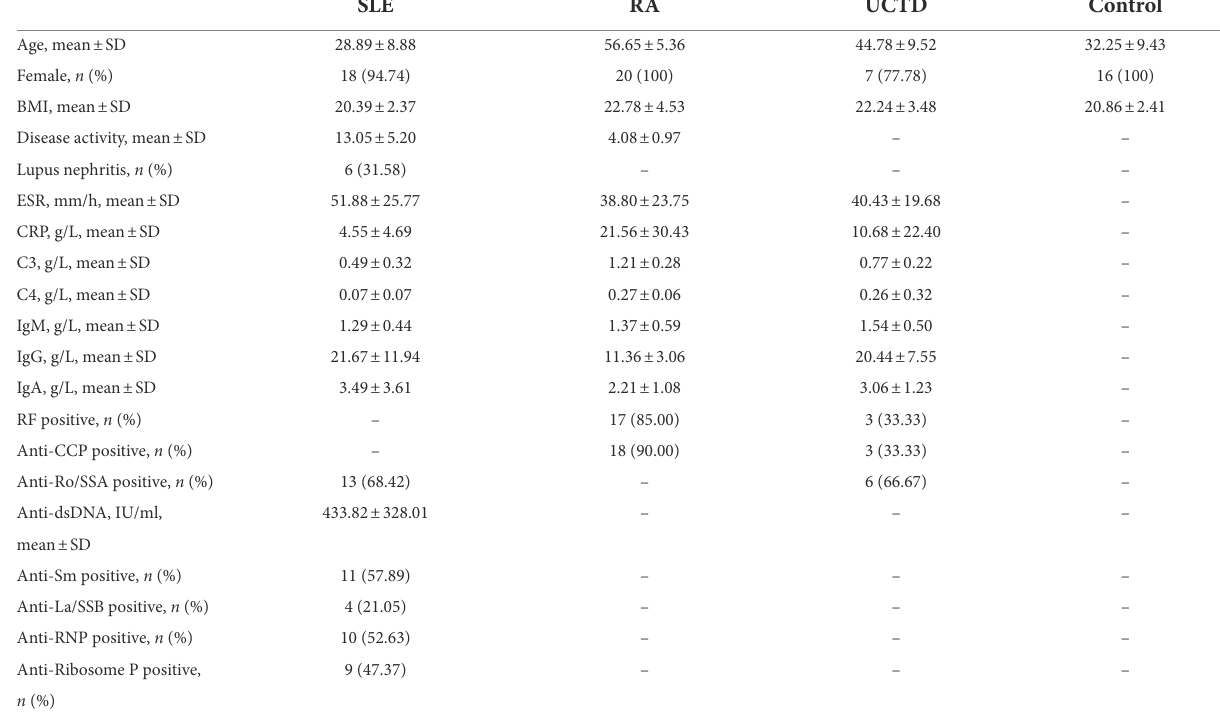
TABLE 1 The clinical and demographic characteristics of all